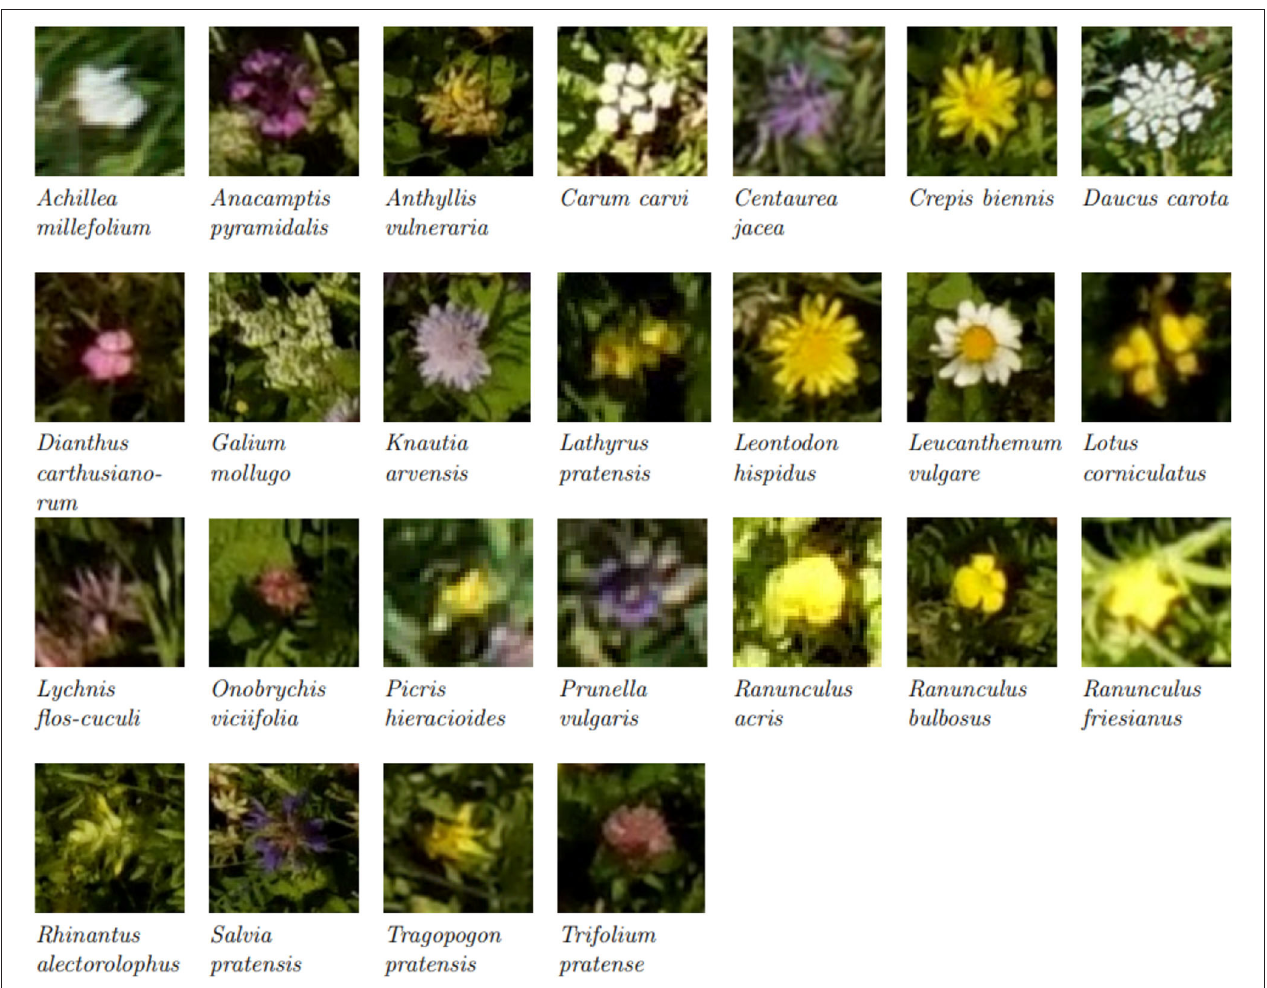
FIGURE 3 | Excerpts from aerial images of the most common flower species. Please note that the images have been scaled to show the flower heads, and thus the pixel size is not consistent between the excerpts. (For images with real relative scaling, please refer to Supplementary Section A.3